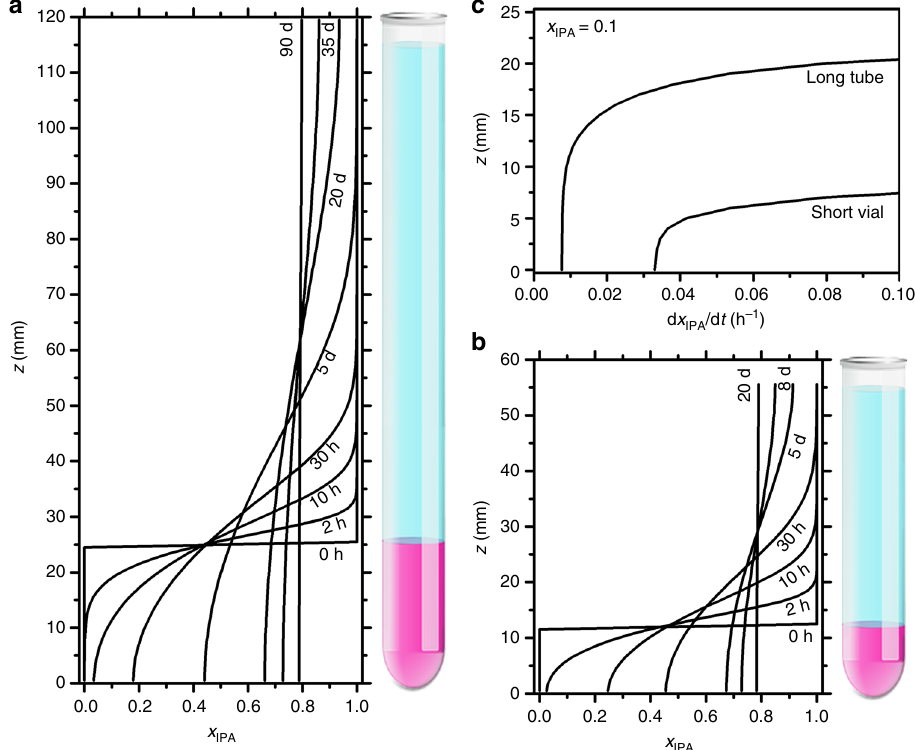
Fig. 5 Simulated solvent composition during counter-diffusion. a Slow and b fast diffusion. The corresponding schematics on the side illustrate the initial con fi guration of the liquid column (purple: gold NPs in toluene; blue: IPA). c Spatial distribution of diffusion speed when x IPA reached 0.1